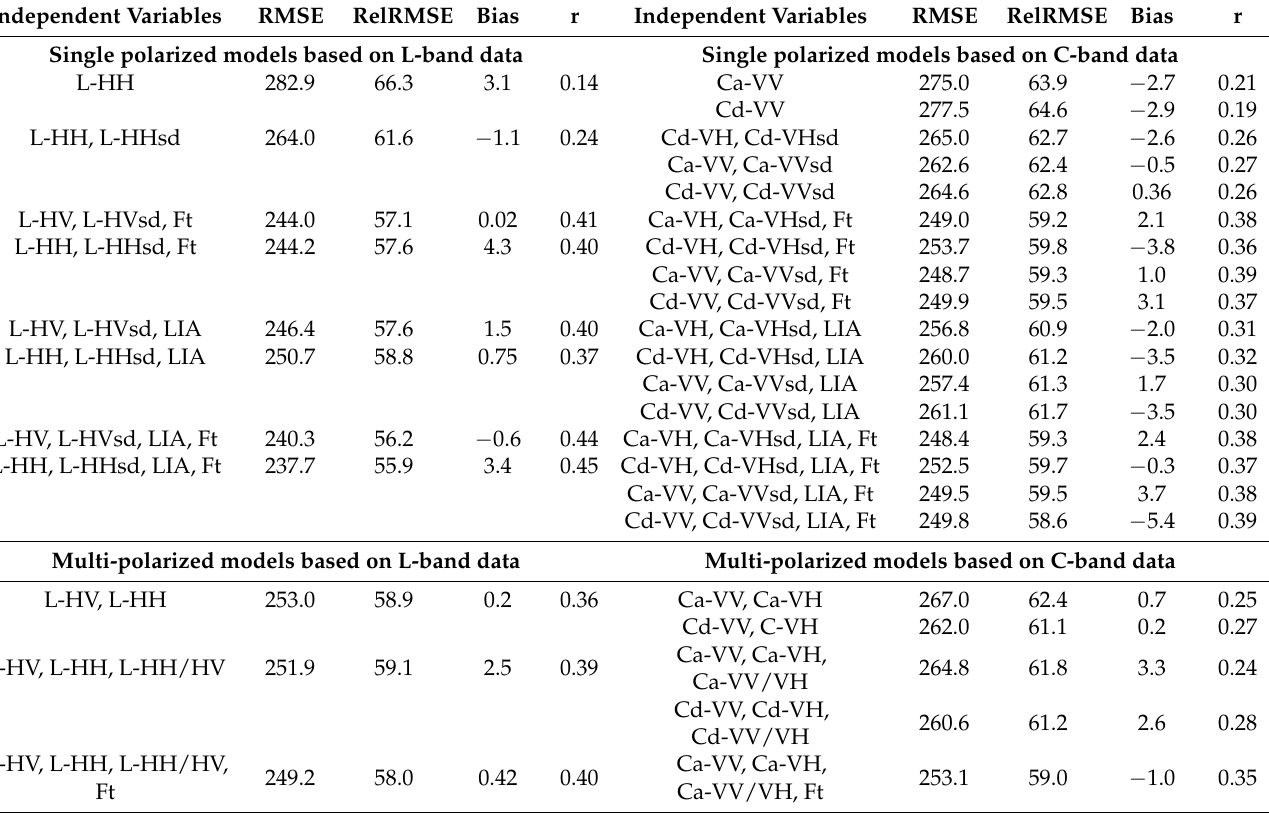
Table A1. GSV accuracy as a function of the selected independent variables for a range of configurations. Abbreviations as follows: RMSE—root mean squared error, RelRMSE—relative RMSE, r—Pearson’s correlation coefficient, L—stands for L-band, C—stands for C-band, H—horizontal, V—vertical, a—ascending pass, d—descending pass, sd—standard deviation, Ft—forest type, and LIA—local incidence